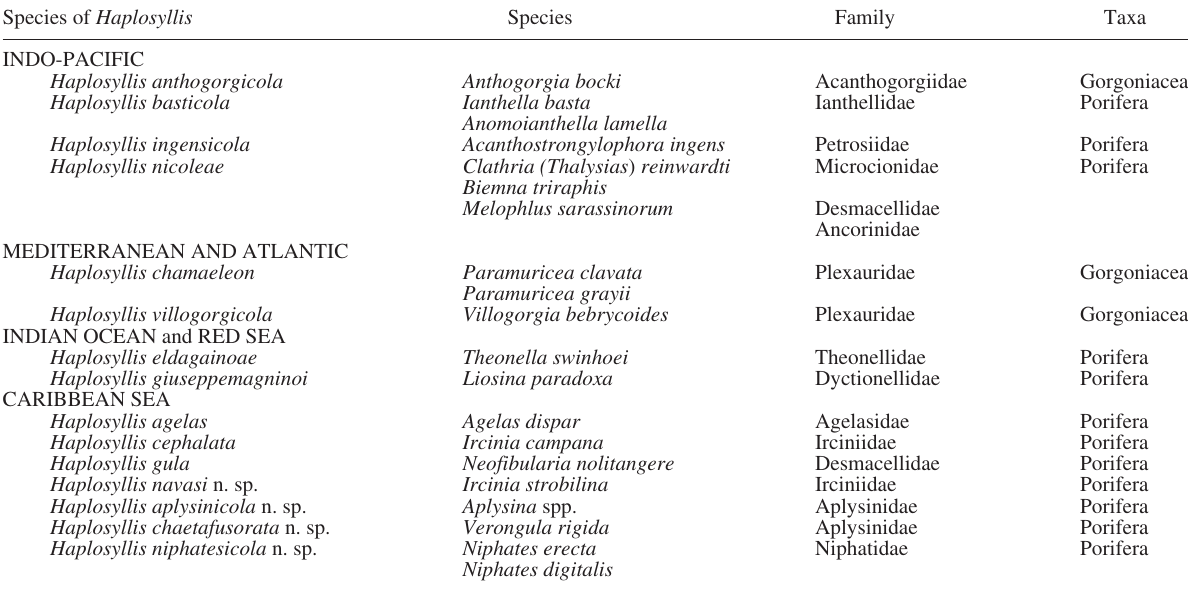
Table 1. – List of the 16 species of Haplosyllis with known hosts, arranged according to geographical distribution. Species of